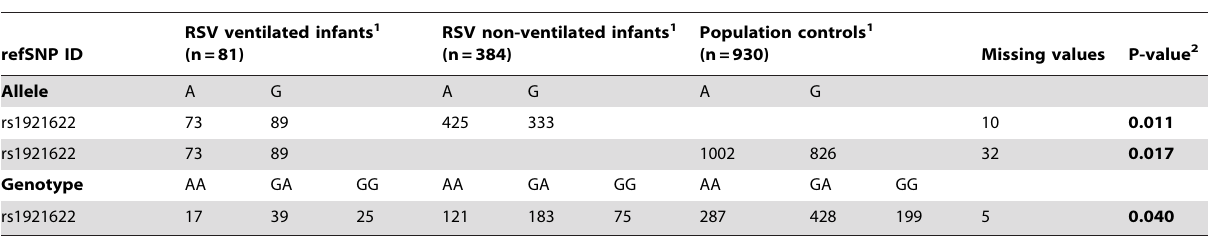
Table 2. IL1RL1 SNP rs1921622 associated with severe RSV bronchiolitis.